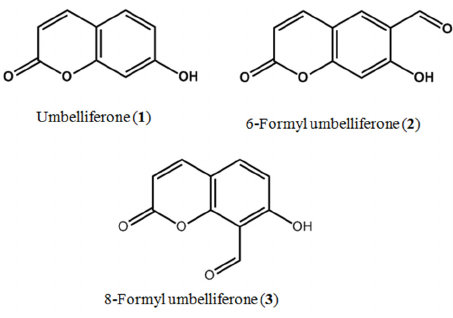
Figure 1. Chemical structures of umbelliferone, 6-formyl umbelliferone, and 8-formyl umbelliferone. Table 1. Electric eel acethylcholinesterase, horse serum butyrylcholinesterase, and human recombinant BACE1 inhibitory activity of coumarins from Angelica decursiva . Compounds